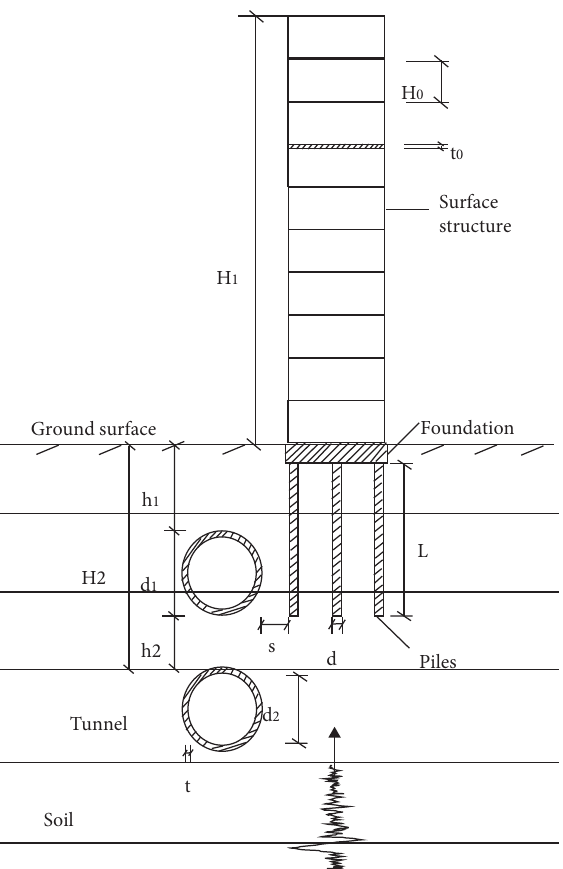
Figure 1: The prototype of the tunnel-soil-surface structure system.